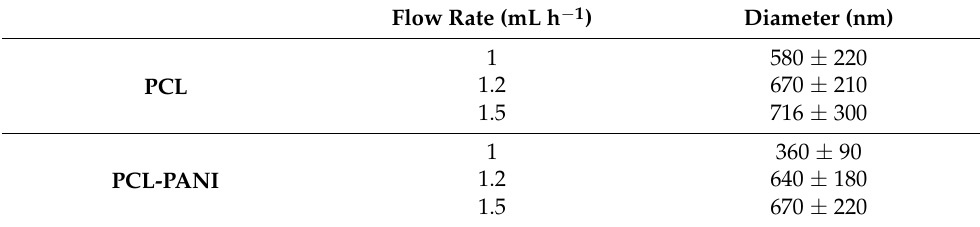
Figure 1. FESEM images of polycaprolactone (PCL) and PCL-polyaniline (PANI) electrospun membranes, obtained by varying the flow rate between 1 and 1.5 mL h − 1 (scale bar = 10 µ m, magnification = 2 K × ). Arrows indicate fiber defects. Table 1. Correlation between flow rate used for PCL and PCL-PANI membrane preparation and diameter of fibers.